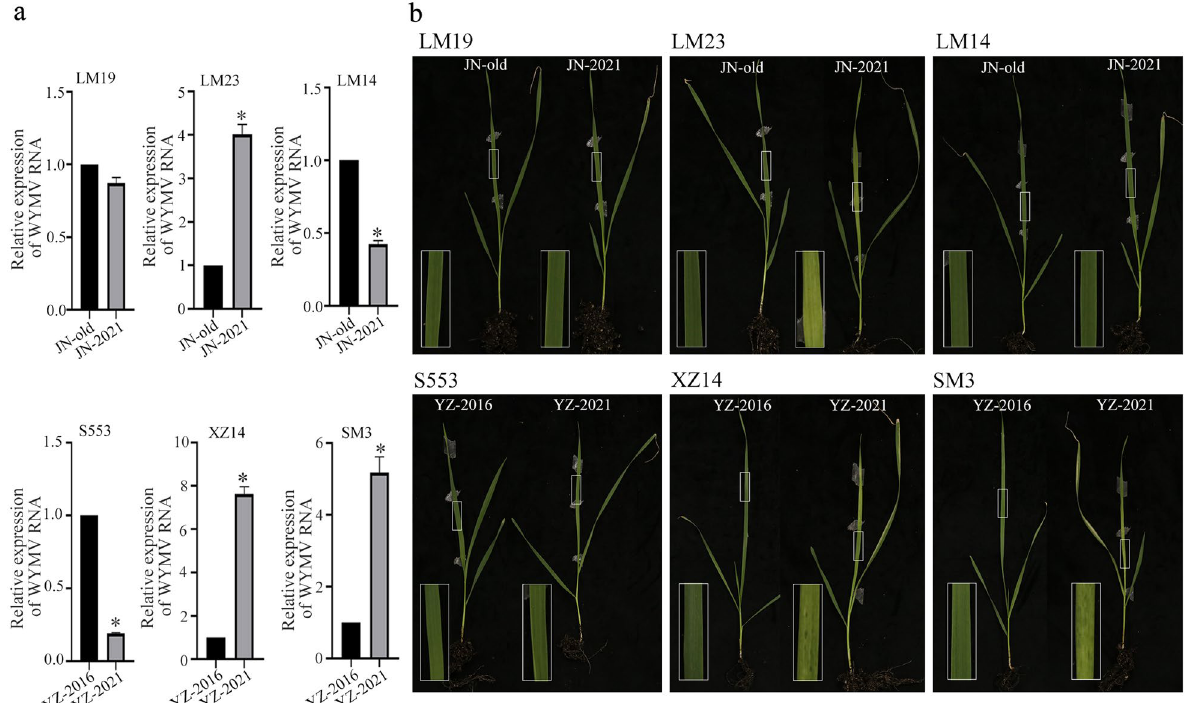
Fig. 4 Natural variation of coat protein (CP) from different WYMV isolates enhanced WYMV infection in several wheat resistance cultivars. a Relative expression of WYMV RNA in systemic leaves of wheat resistance cultivars inoculated with JN-old or JN-2021 and YZ-2016 or YZ-2021. LM 19, LM23, and LM14 are resistance cultivars in Junan. S553, XZ14, and SM3 are the resistance cultivars in Yangzhou at 28 days post-infiltration (dpi). JN-old and YZ-2016 represent for WYMV infectious clones containing CP from a previous WYMV isolate in Junnan and Yangzhou, China (Junan-old and Yangzhou-2016). JN-2021 and YZ-2021 represent for WYMV infectious clones containing CP from WYMV isolates Junan-2021 and Yang-2021 which obtained in this study. The values were normalized to those for the reference gene ( TaCDC ) and are presented as fold changes in expression relative to that in wheat leaves inoculated with JN-old or JN-2021 and YZ-2016 or YZ-2021. Asterisks indicate significant differences in expression between wheat leaves inoculated with JN-old and JN-2021 or YZ-2016 and YZ-2021 when analyzed using a Student’s t -test ( P < 0.05). b The phenotype of wheat plants inoculated with the infectious clones containing CP of WYMV isolate from Junnan and Yangzhou,